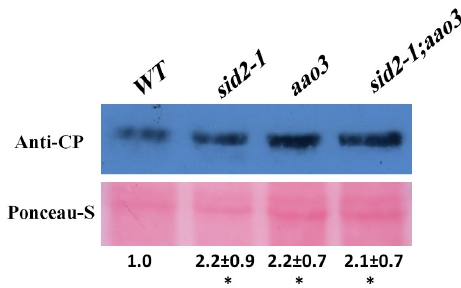
Figure 3. The susceptibility of wild type (WT) and ABA and SA mutant seedlings to BaMV. Six-day- old seedlings of the WT, sid2-1 , aao3 , and sid2-1:aao3 were infected with a BaMV infectious clone (pKB) using Agrobacterium-mediated transformation (AGROBEST method). Total proteins were extracted 4 days later, and BaMV coat protein was quantified by Western blot analysis as indicated in the figure. The experiment was carried out in 3 biological replicates with similar results (Figure S2). Band densities (anti-CP and RuBisCO from Ponceau-S staining) were measured with Image J software, and the CP level in each line was normalized to the corresponding Rubisco band. Values are means ± SD of three biological replicates. An asterisk indicates a significant increase relative to the WT (which was set at 1.0) according to a one-sided Student’s t -test ( p <